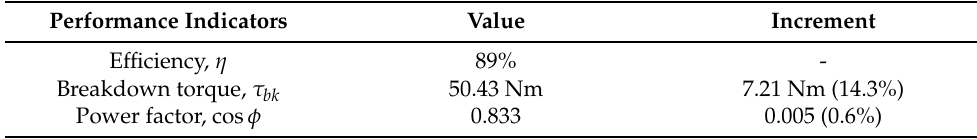
Table 9. Performance of IM after